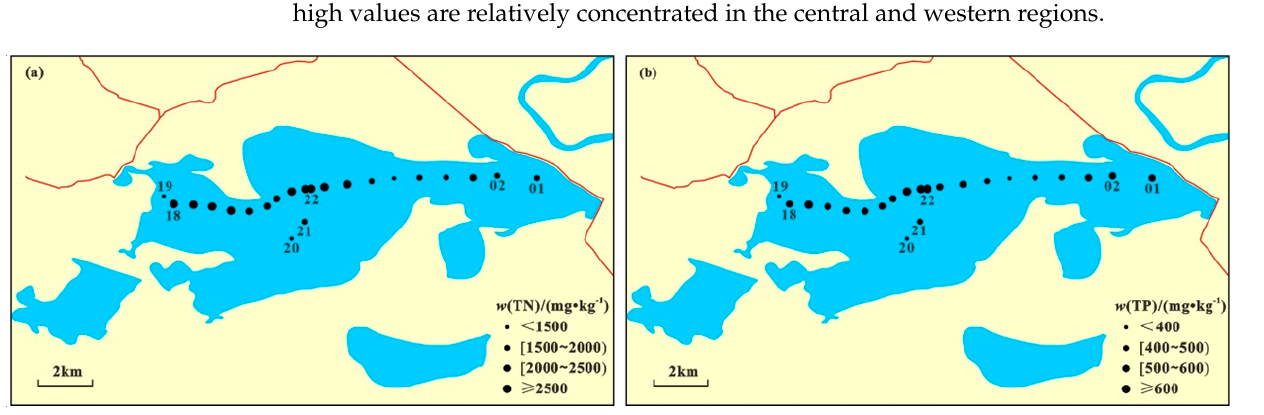
5 of 19 Table 1. The classification criteria of the potential ecological risk index. i r E